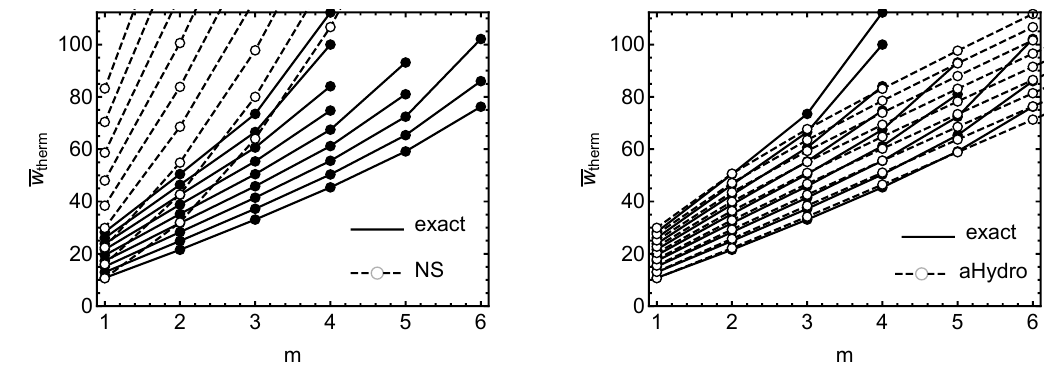
Figure 13 . Scaled thermalization time w therm as function of m . The di(cid:11)erent lines correspond to di(cid:11)erent values of n . The left panel shows a comparison with vHydro and the right panel shows a comparison with